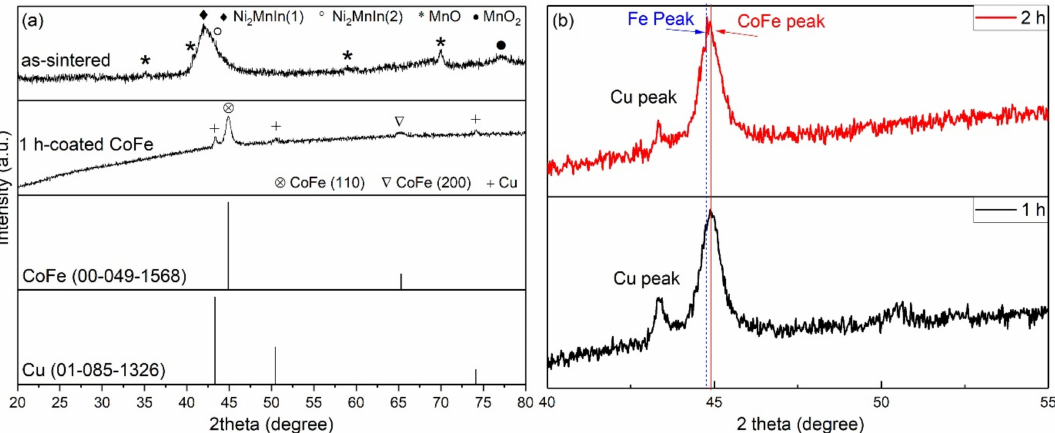
Figure 2. Room-temperature XRD patterns of ( a ) the as-sintered sample and the sample with 1 h- coated CoFe and ( b ) the magnified pattern of 1 and 2 h CoFe-coated alloy.